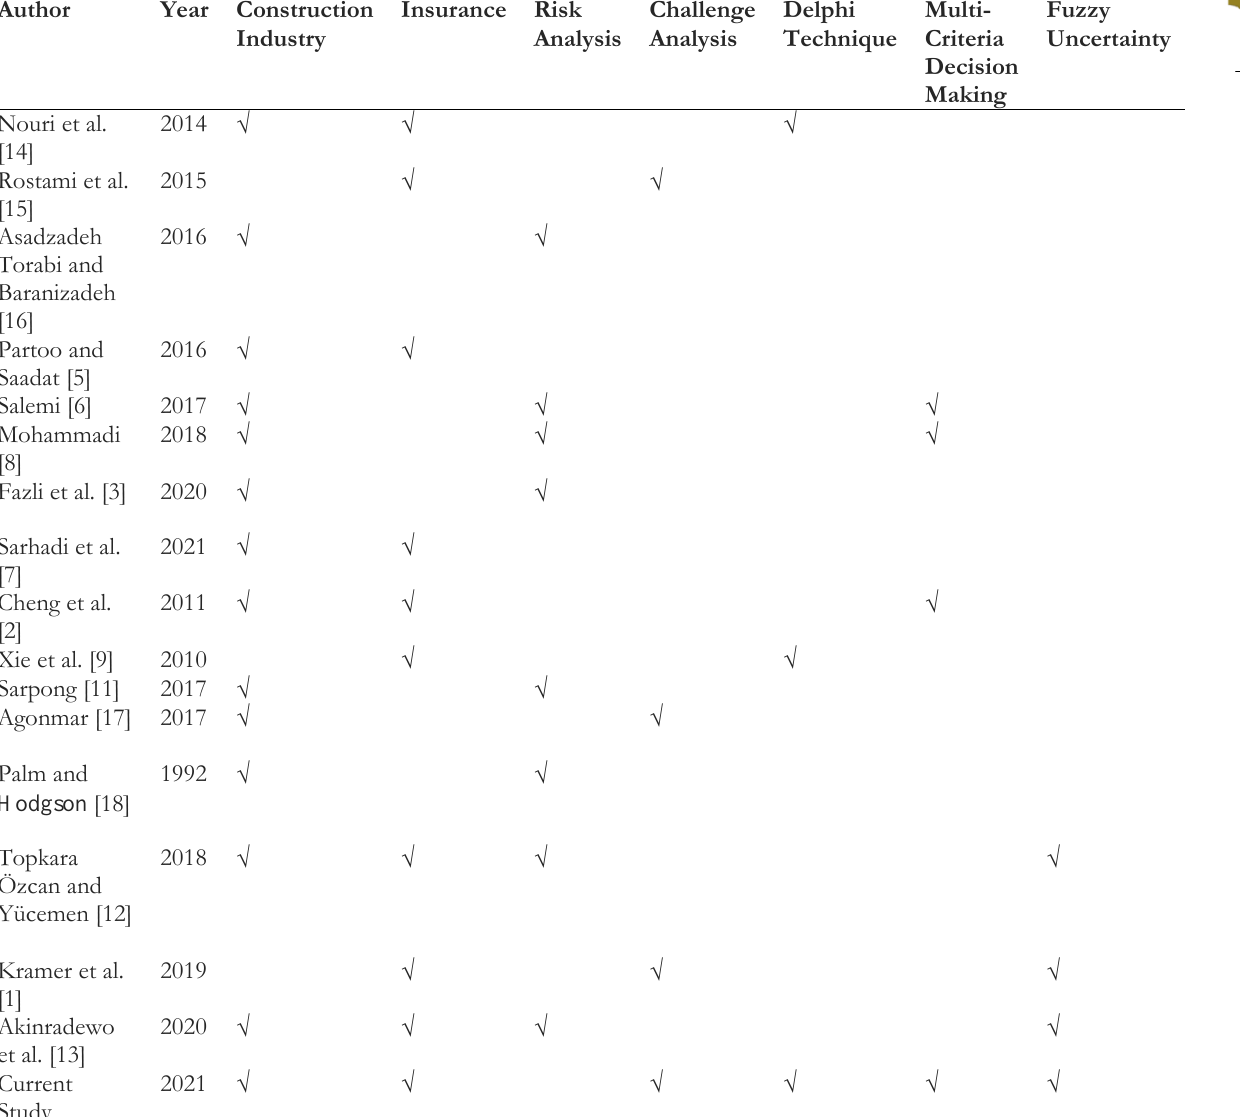
Table 1. Summary of literature